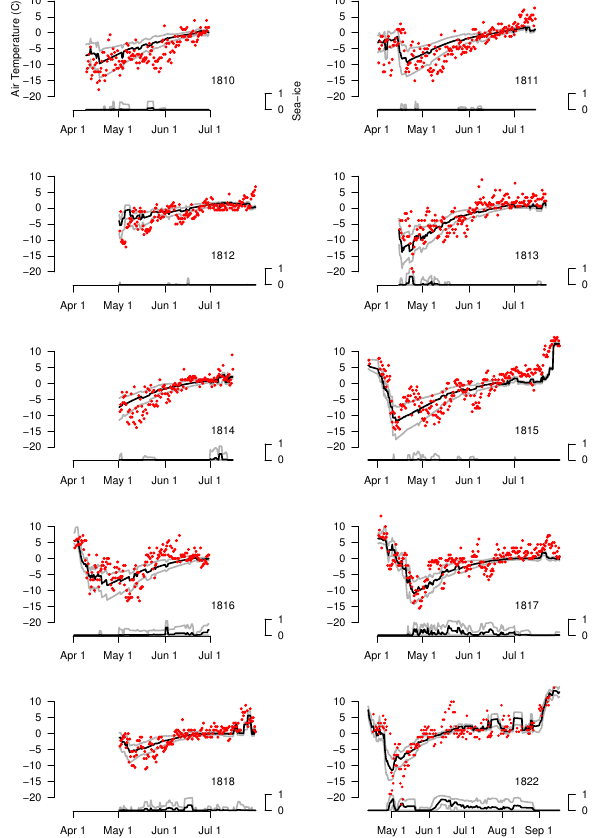
Fig. 2. Weather observations from William Scoresby’s whaling voyages, air temperatures from each of 10 seasons compared with modern values. The red points are the observations, the black and grey lines are the mean, max and min values from modern datasets (monthly averagesinterpolatedtodaily,1979-2004;ATfromRigoretal.(2000),sea-icefromRayneretal.(2003)).